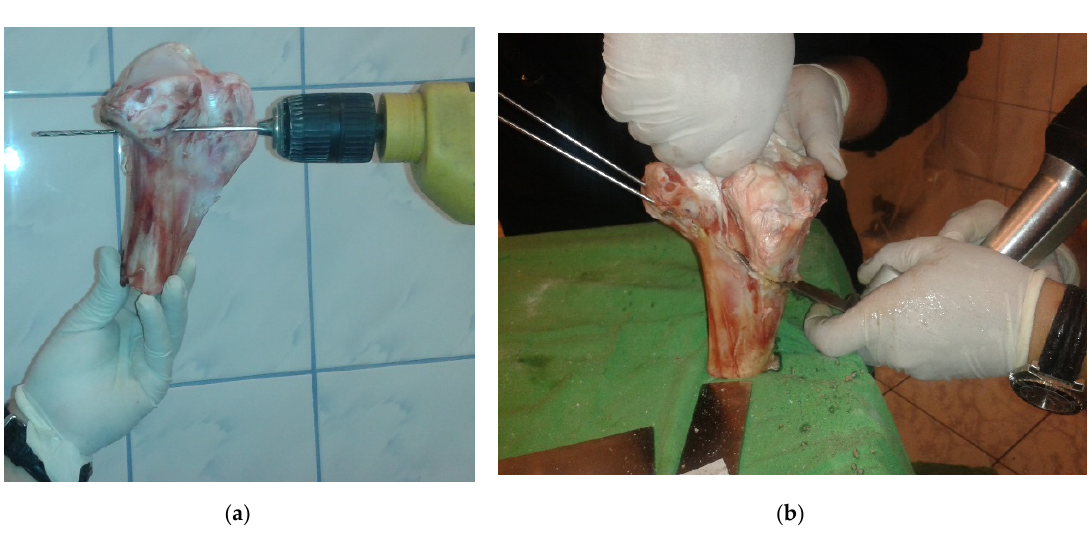
Table 2. The values of the stresses resulted from the finite element method (FEM) analyses.